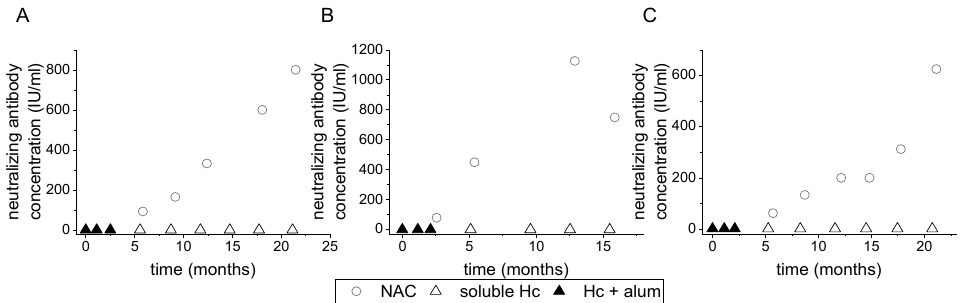
Figure 3. Immunization of horses with recombinant botulinum H C subunits. Graphs present the immunization schedule (triangles) and neutralization titer (circles) in horses immunized with recombinant H C /A ( A ), H C /B ( B ), and H C /E ( C ). The first three immunizations (black triangles) consisted of 10 mg of recombinant H C fragment adsorbed to alum hydroxide, whereas all subsequent injections (white triangles) contained 20 mg soluble Hc fragments.